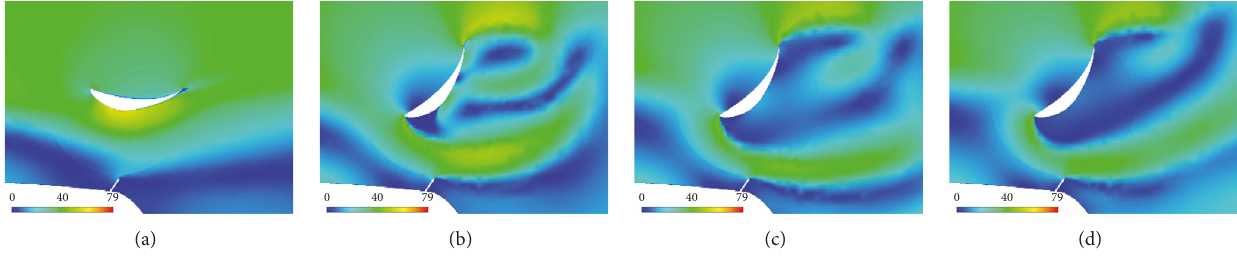
Figure 13: Contours of the velocity in the symmetry plane while the wing is moved to 50 ∘ at the following time frames: (a) 0.25 s, (b) 0.50 s, (c) 0.55 s, and (d) 0.60 s. Table 1: A comparison of the aerodynamic coefficient values for different variants of the tested car model. Drag coefficient Lift coefficient Base